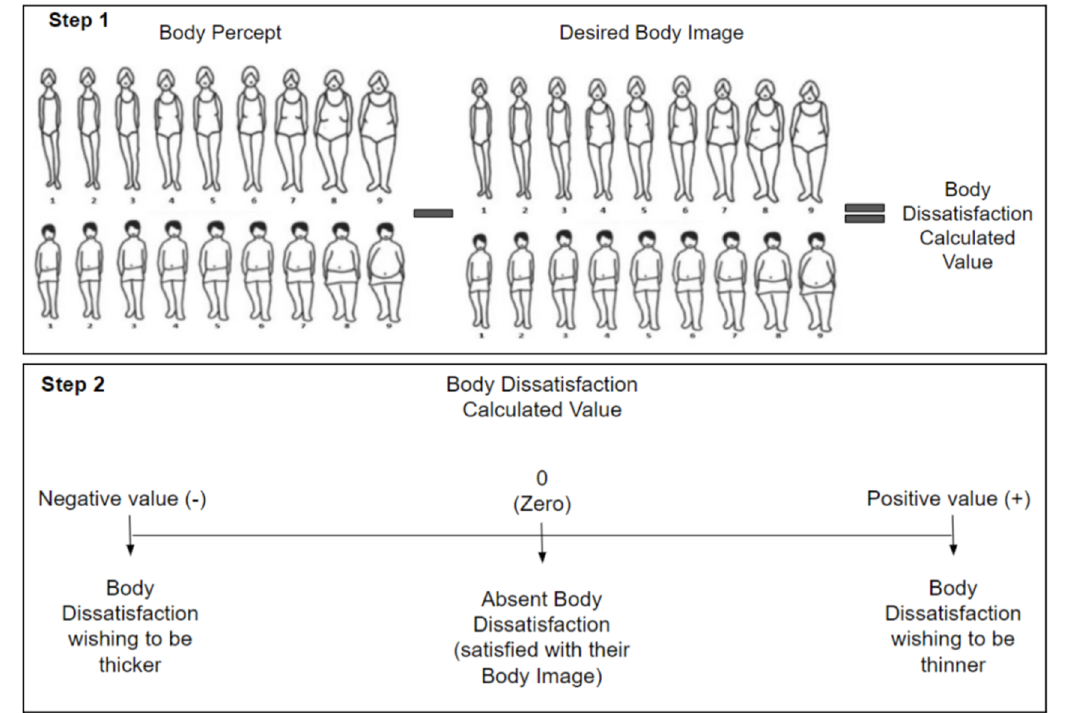
Figure 1. Body Dissatisfaction Assessment.